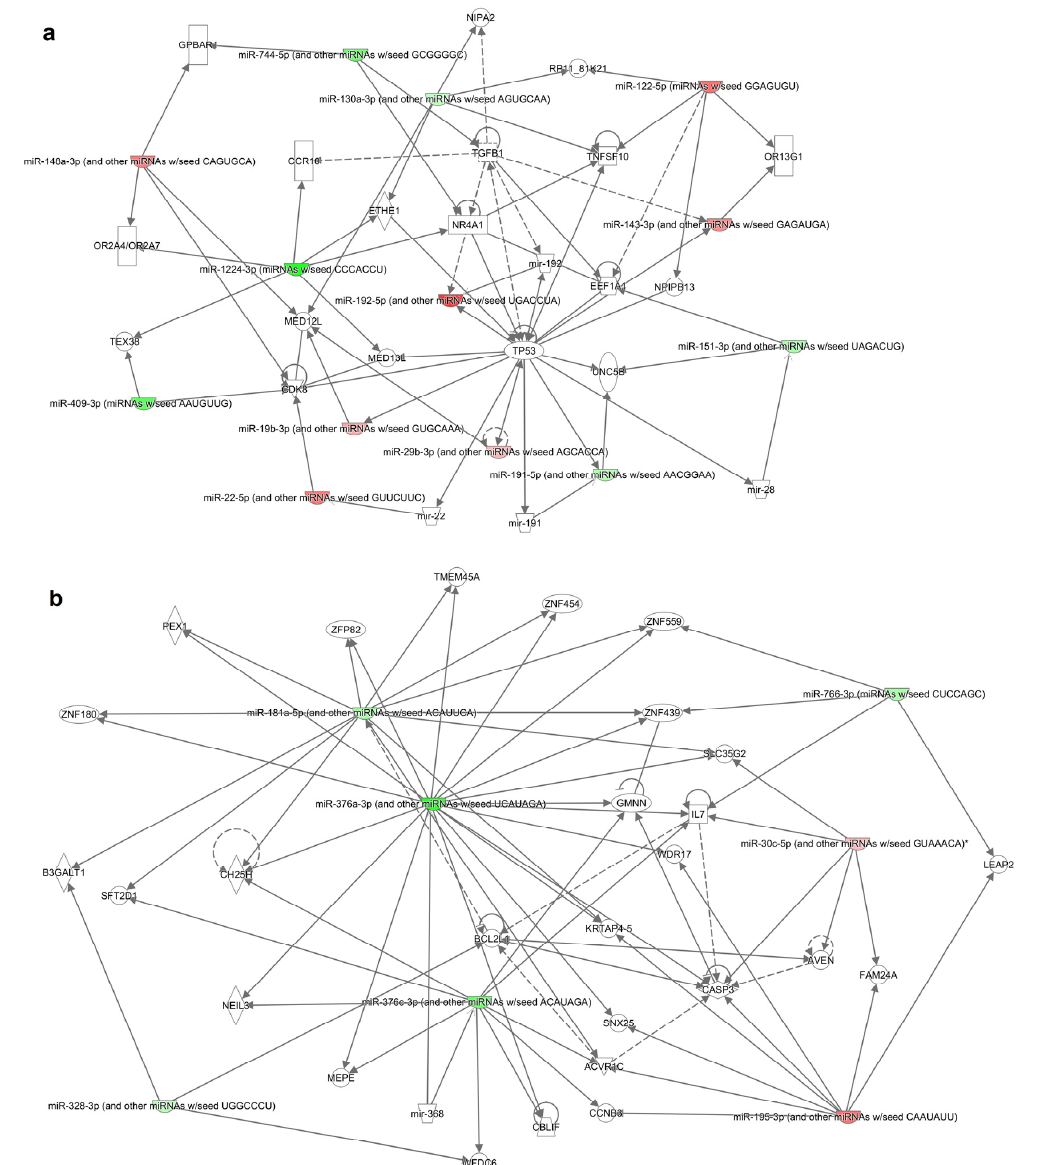
Figure 3. Gene networks ( a , b ) identified from the differentially expressed miRNA’s target genes list generated by IPA. Solid and dotted lines indicate direct and indirect relationships, respectively. Color intensity indicates upregulation (red) and downregulation (green).